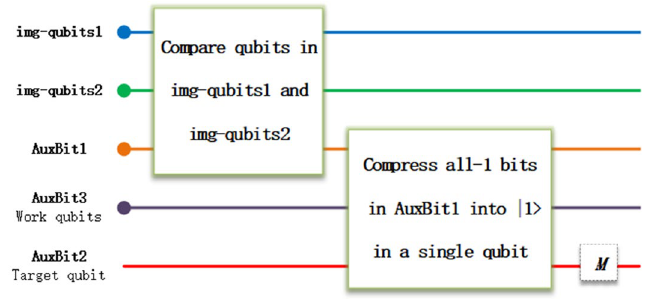
Figure 1. Three steps in comparing the similarity between two quantum images. Different colors represent qubits carrying different functions. The dot on endpoint indicates a multi qubits string. M represents measurement